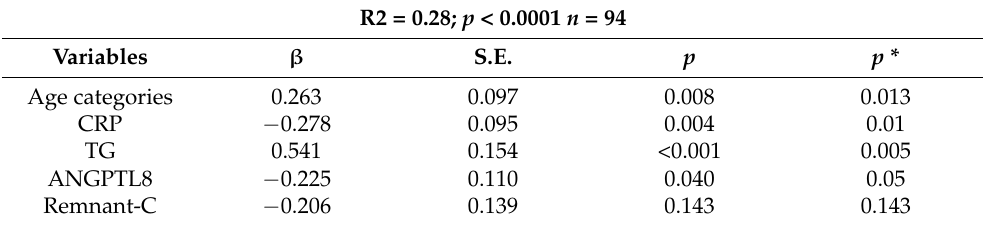
Table 4. The stepwise multiple linear regression analysis between ANGPTL3 and selected variables.